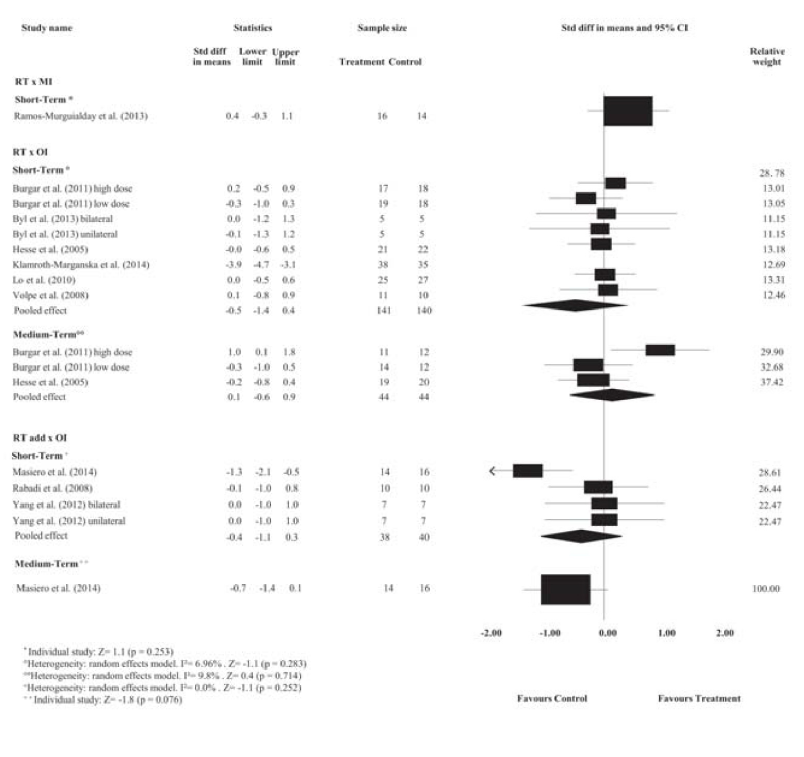
Fig 3. Standardized mean difference (95% CI) comparing RT or additional effect of RT versus OI or MI for spasticity of people with limited upper limb function. RT = Robot-assisted therapy; RT add = additional effect of Robot-assisted therapy; OI = other intervention; MI = minimal